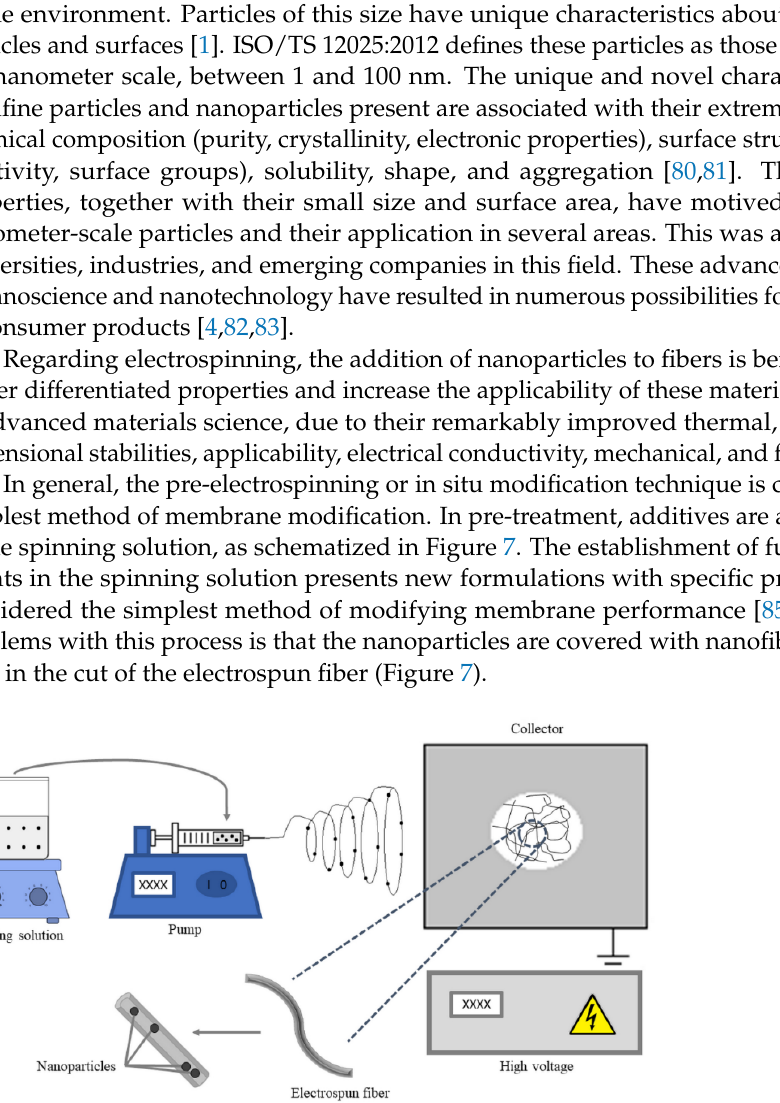
Figure 7. In situ modification technique